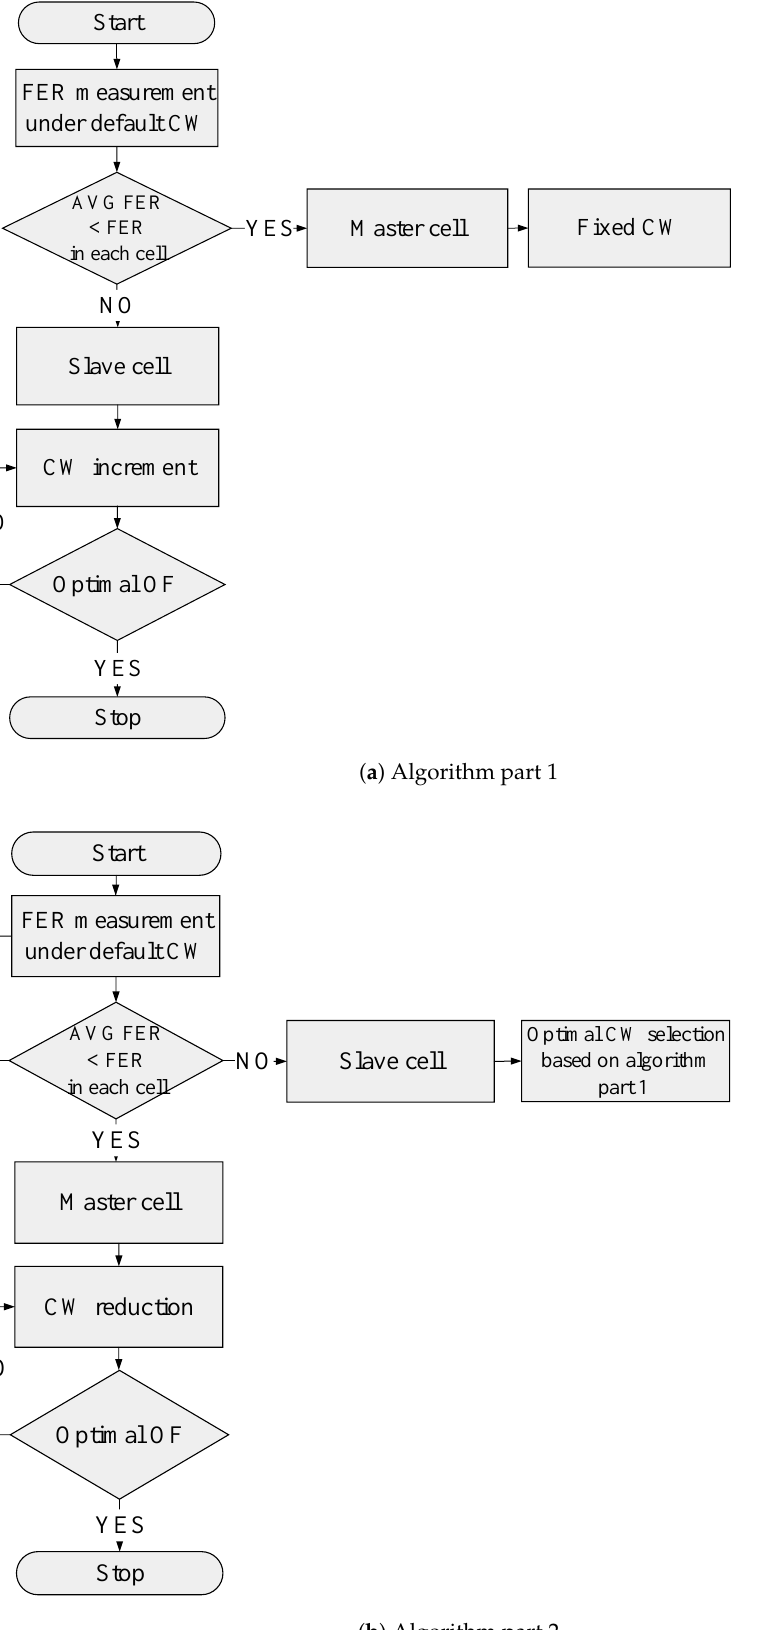
Figure 5. Flow graph of the AP coordination based optimization